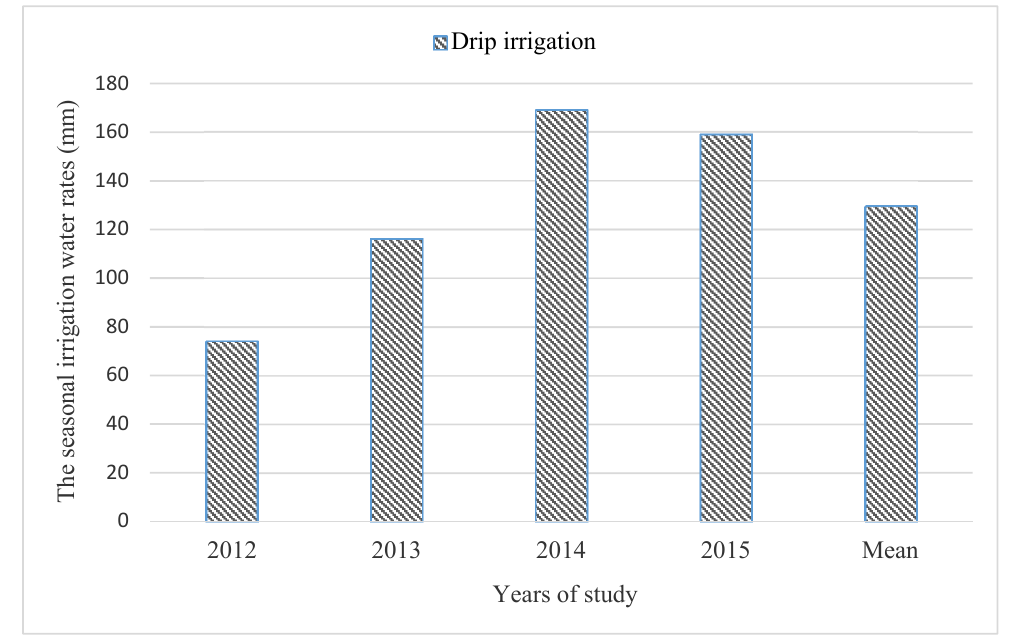
Figure 1. The seasonal water rates (mm) used for irrigation of two watermelon cultivars: Bingo and Sugar Baby during the years